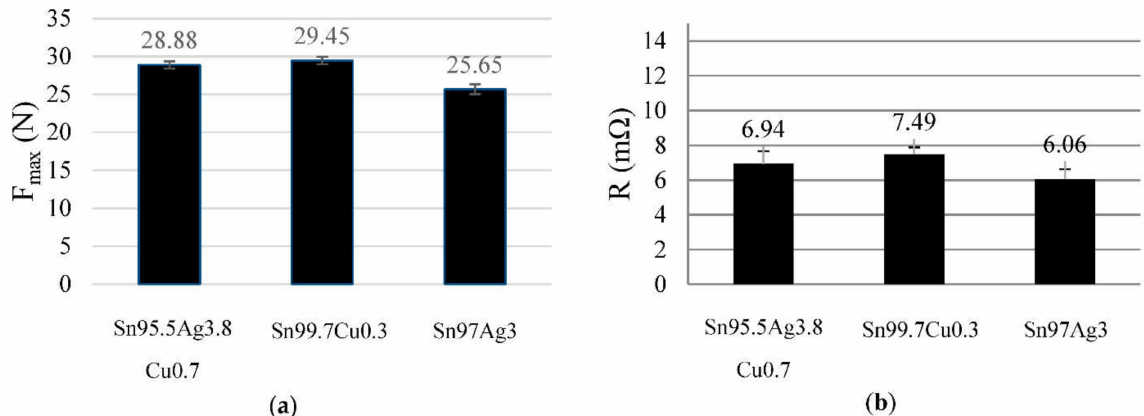
Figure 5. ( a ) Results of the peeling test and ( b ) resistances depending on the solder alloy.